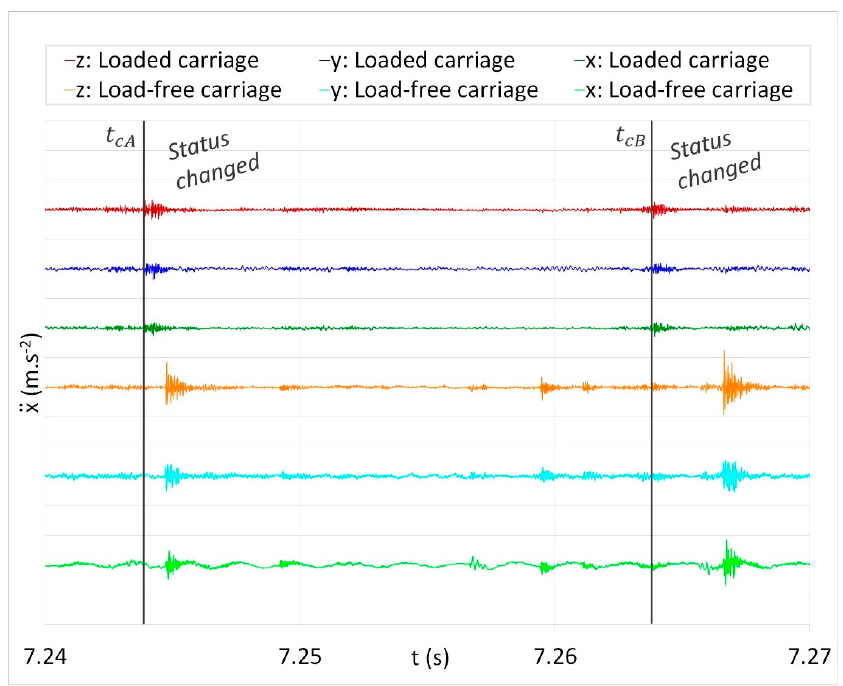
Figure 20. The time graph of acceleration by loaded carriage crossing over the simulated damage: ordinate tick marks: 100 ms − 1 , processed in DeweSoft.